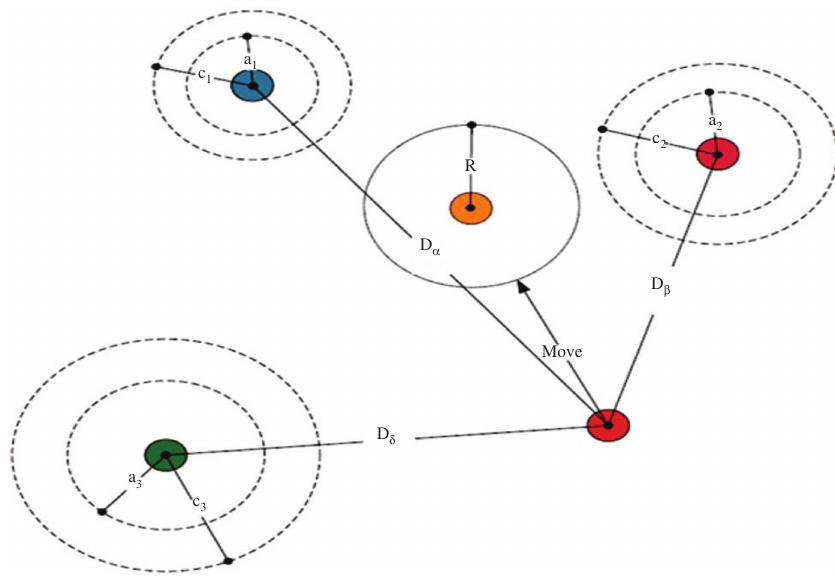
Figure 2: Updating the Wolves’ Positions in the GWO